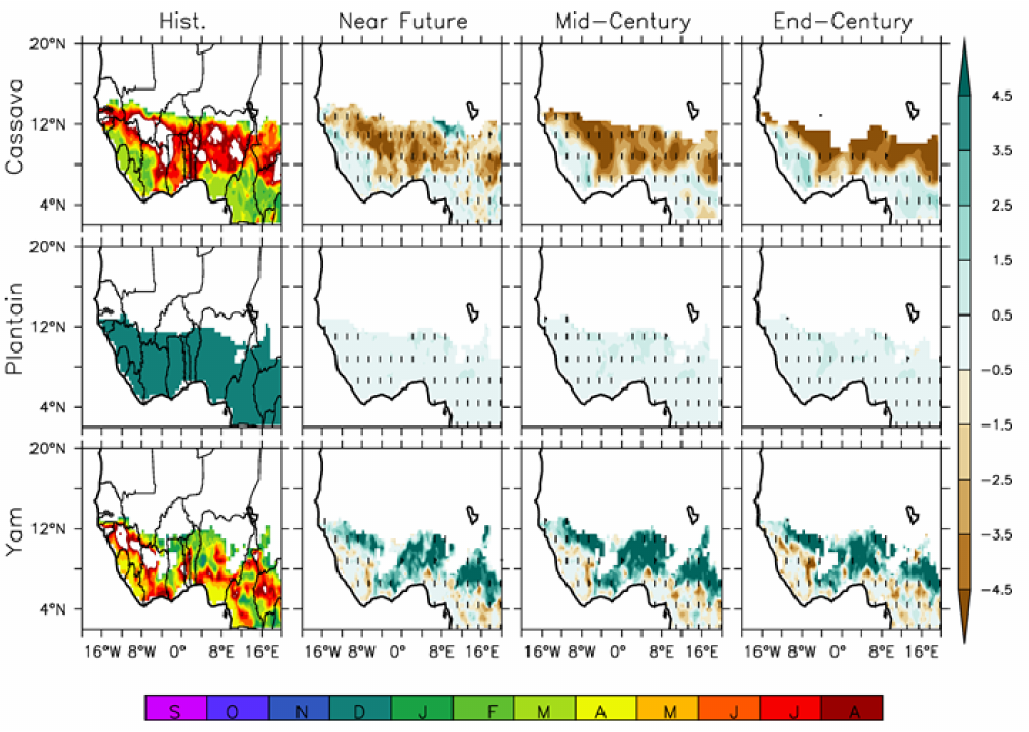
Figure 9. Same as Figure 7 but for the root and tubers, cassava, plantain and yam.